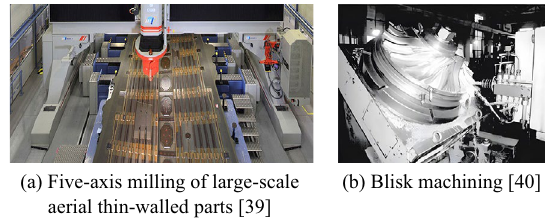
Figure 11 Multi-axis machining of large-scale complex structural parts: a Five-axis milling of large-scale aerial thin-walled parts [39];